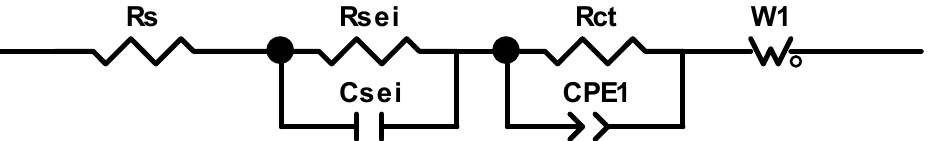
Figure 4. An equivalent circuit of Ge microrods. Reproduced with permission from [32]. Elsevier, 2021. In Figure 4, the element Rs relates to an electrolyte resistance, Rsei is the sei resistance, Csei is the capacitance of the sei, Rct is the charge transfer resistance, CPE is an element with a constant phase shift, and W1 is the Warburg impedance reflecting sodium diffusion in germanium. The calculated parameters of the equivalent circuit are presented in Table 1. Table 1. The calculated parameters of the equivalent